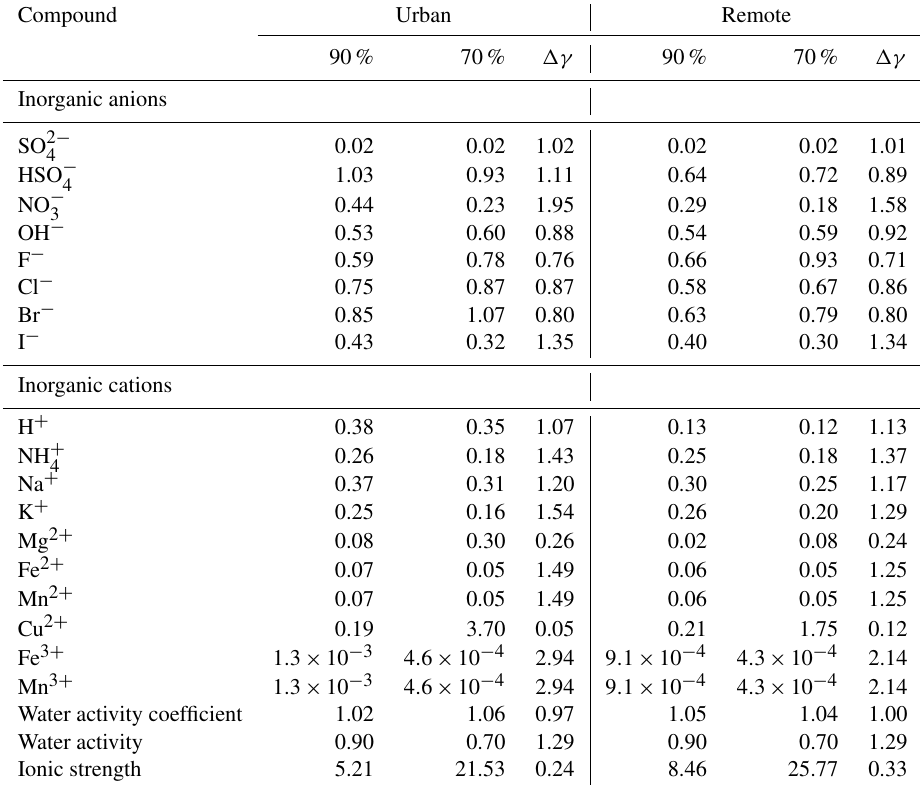
Table 2. Predicted activity coefficients of selected ions and water, as well as the ionic strength in deliquesced particles for the 90% / 70%- NIDR and 90% / 70%-NIDU simulations at 29h. (cid:49)γ represents the ratio of the predicted activity coefficients of the 90% case and the 70% case, respectively. Compound Urban